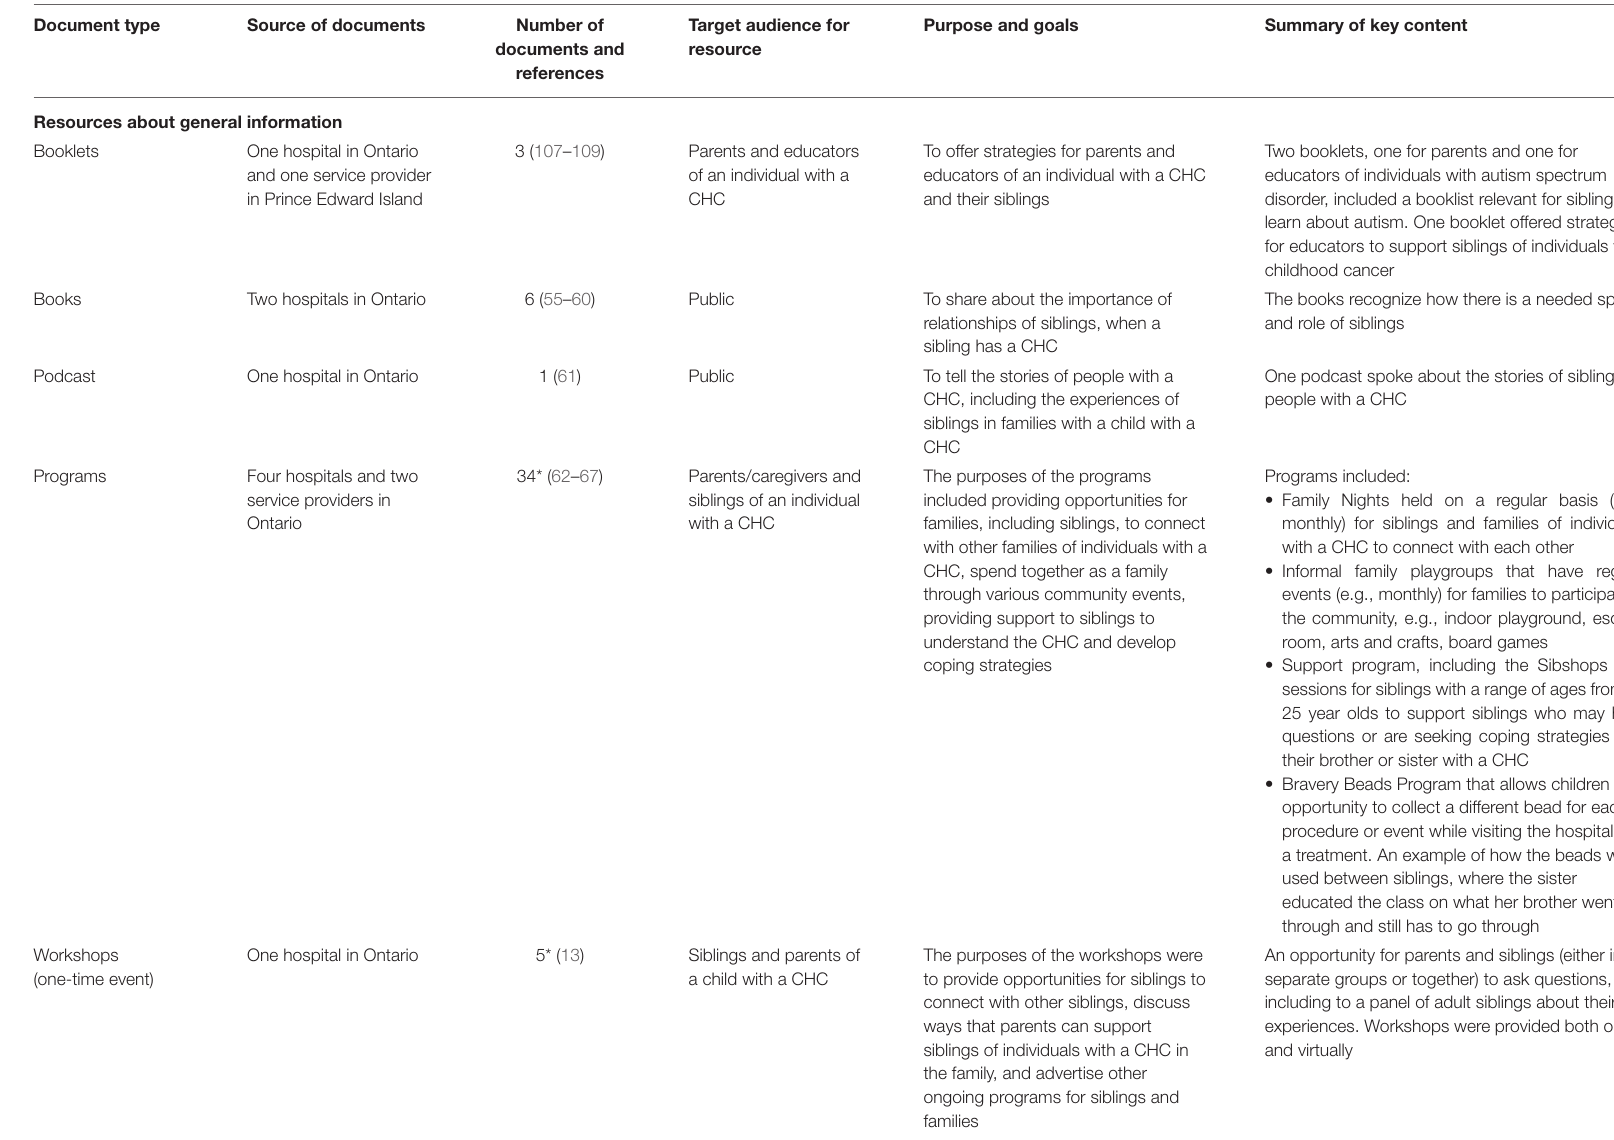
TABLE 1 | Description of